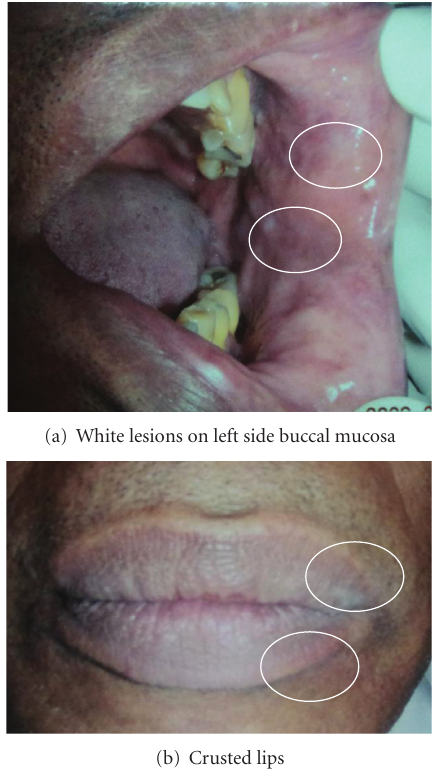
Figure 1: Clinical presentation.